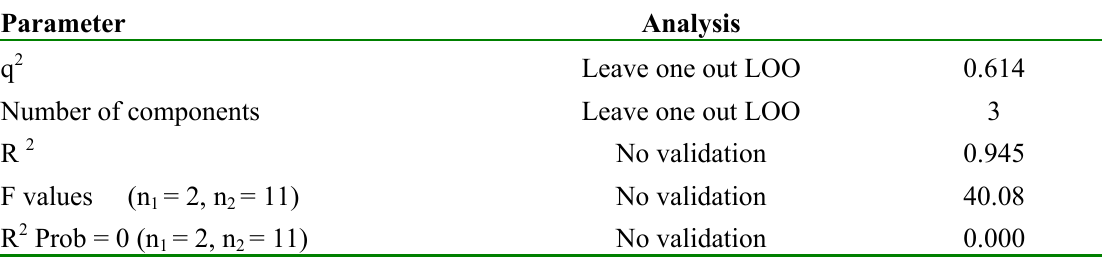
Table 5. Statistical parameters of the CoMFA model for the oxidation microorganisms